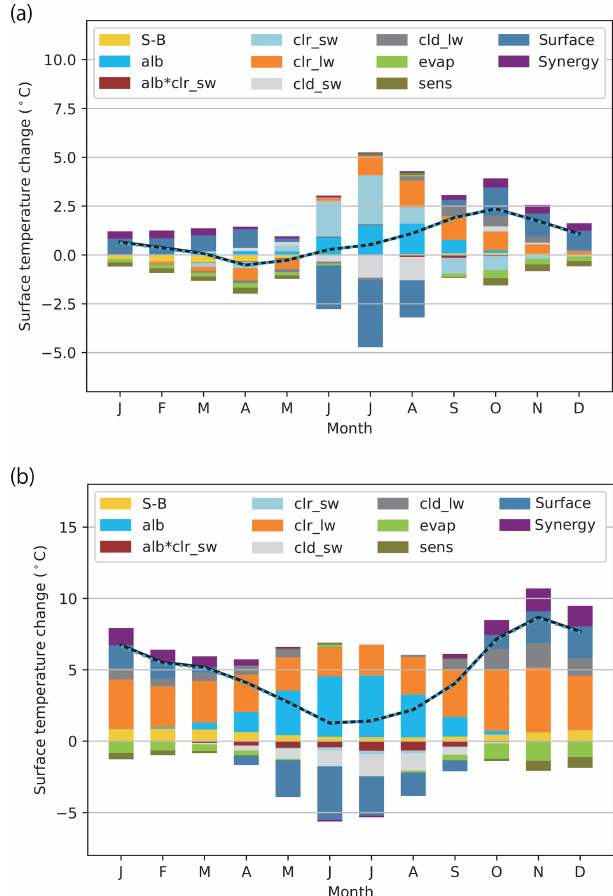
Figure 5. Simulated and diagnosed surface temperature changes ( ◦ C) for the ocean (north of 60 ◦ N): (a) (cid:49) MH and (b) (cid:49) RCP4.5. The solid black polygonal lines denote simulated changes and dashed blue polygonal lines denote the sum of the diagnosed par- tial changes; the two lines are superimposed. The graphs represent the means of all 10 models listed in Table 2. See Table 3 for the interpretation of each